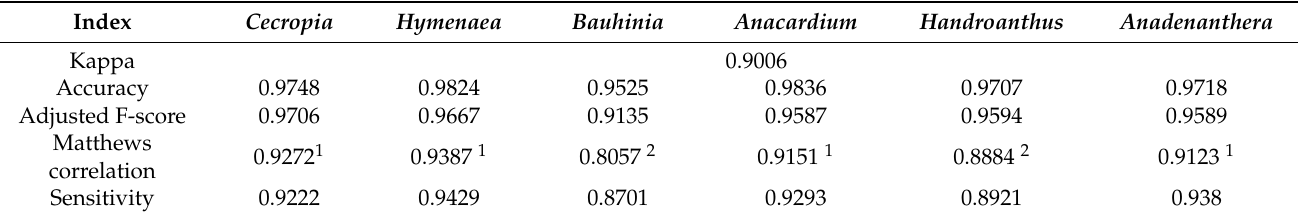
Table 5. Statistics obtained in the training data set classification